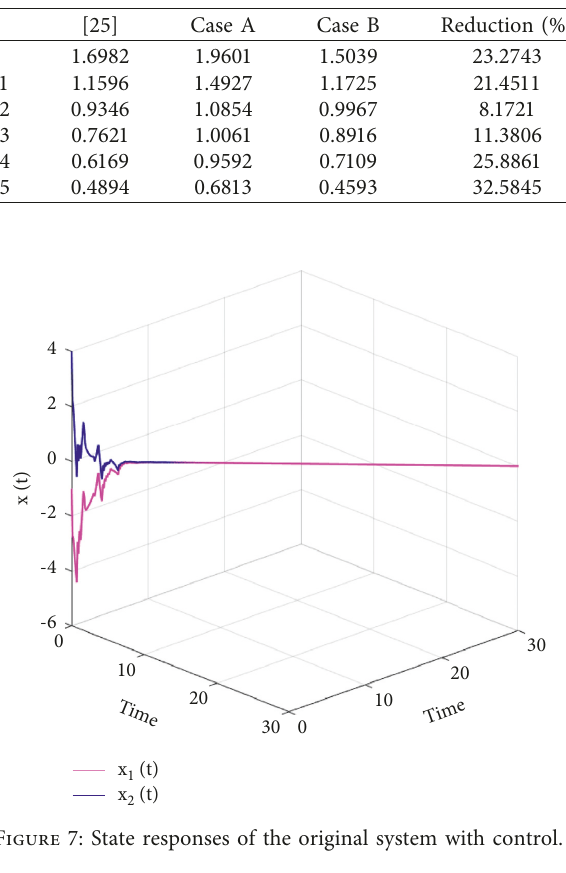
Figure 6: Control input signal u ( t ) . Table 2: MASPs h M for different δ ’s under ICA.